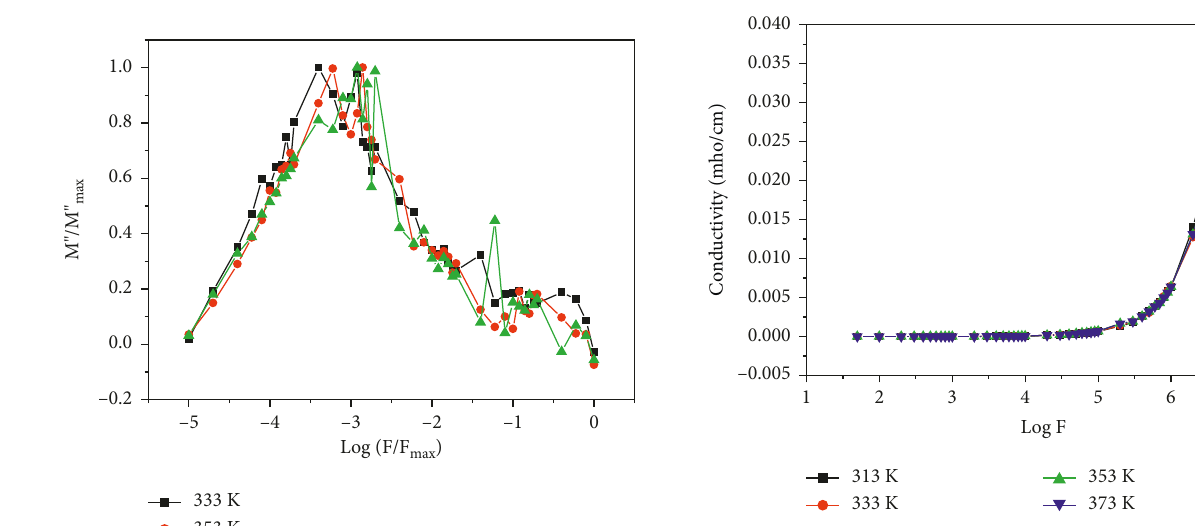
Figure 16: Conductivity vs log F.